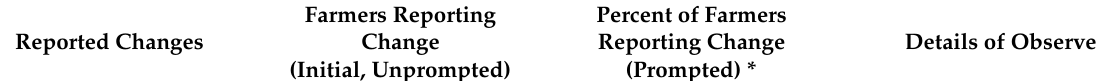
Table 4. Observed changes to fields and crops (unprompted and prompted). Rows in grey display the two foci of our study; they are highlighted to emphasize their low salience for